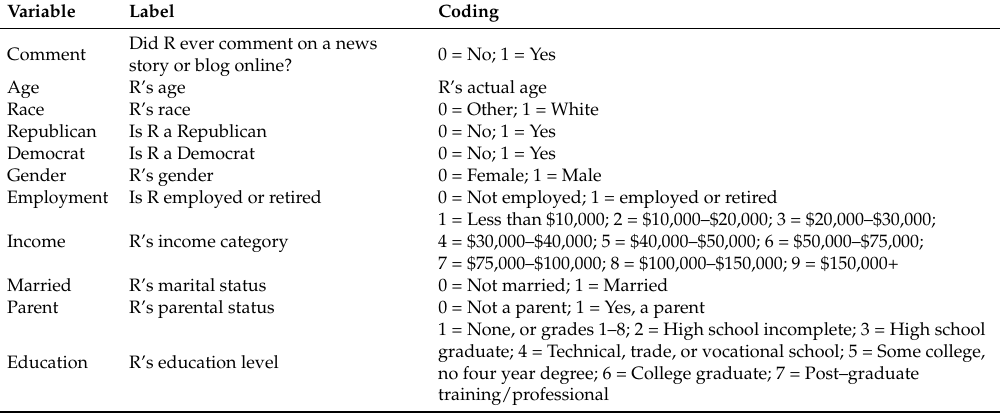
Table A2. Summary of variables used during the 2010 regression